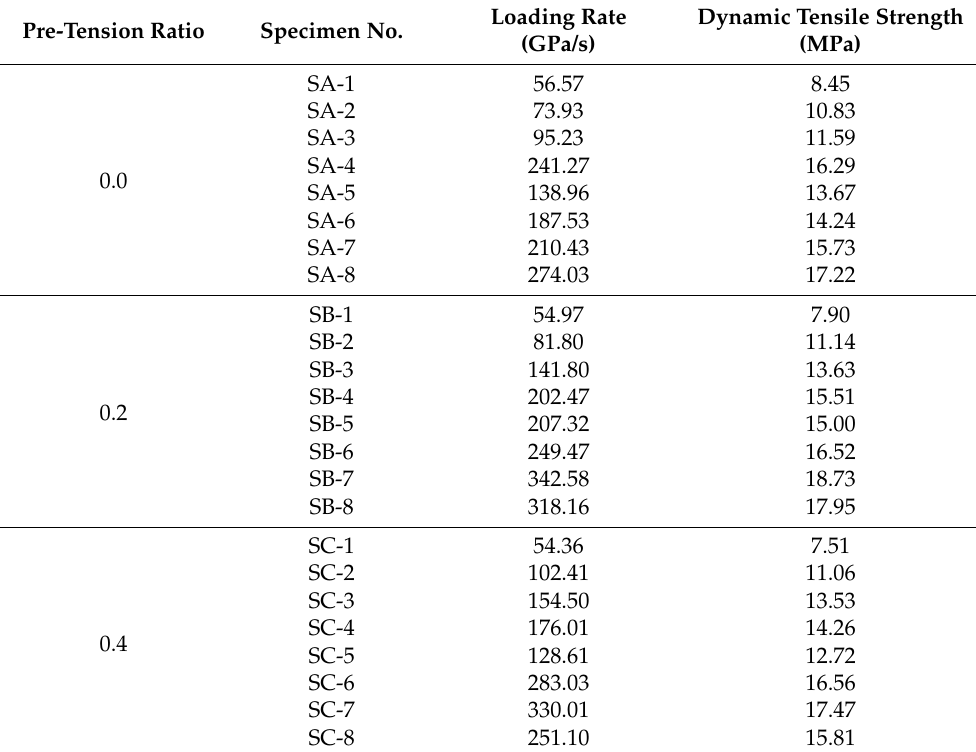
Table 2. Coupled static–dynamic FBD test results of naturally saturated sandstone specimens.